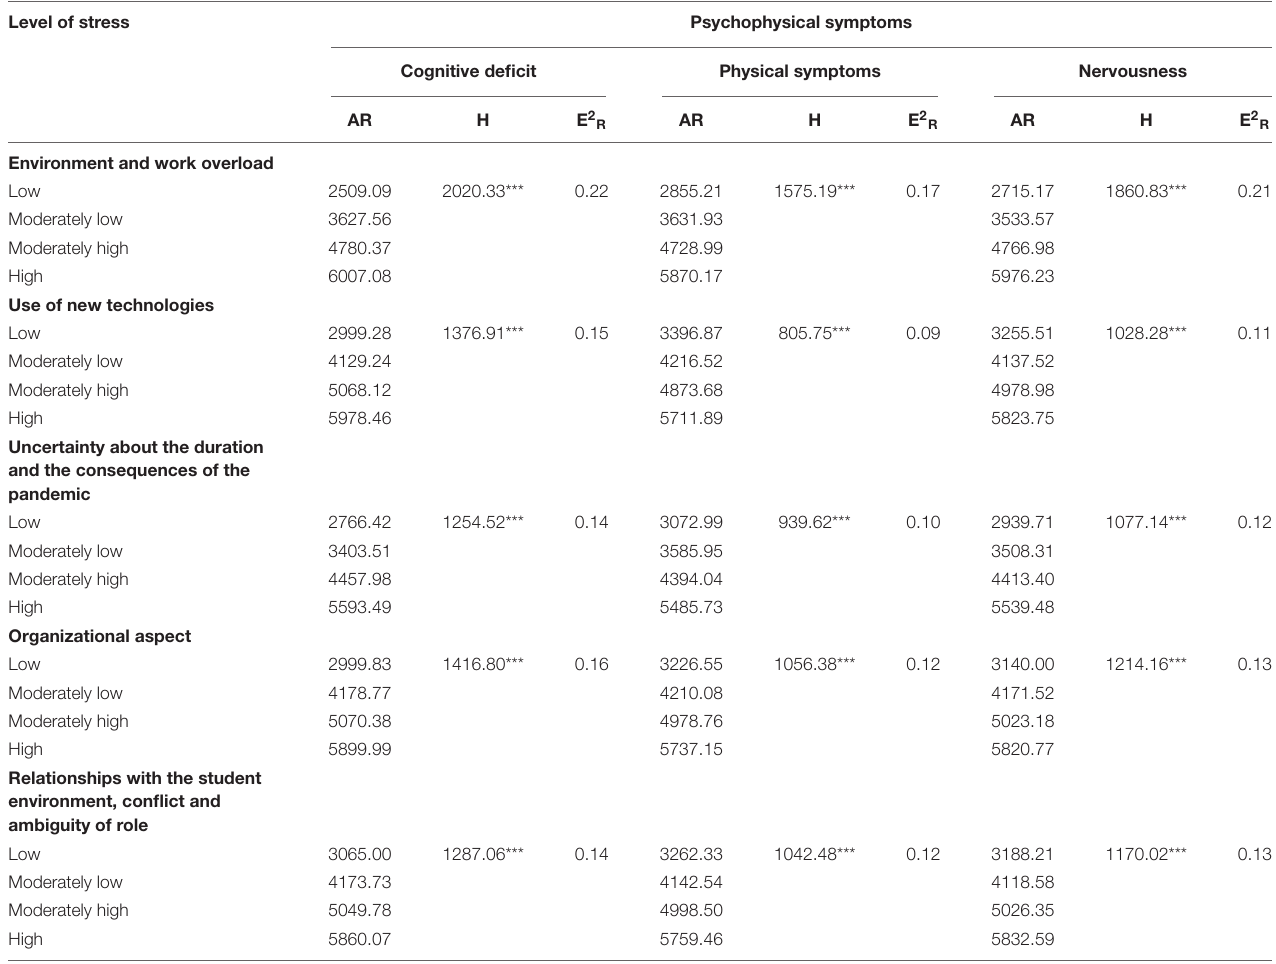
TABLE 3 | Results of the Kruskall Wallis test for the Psychophysical symptoms according to the Level of stress. Level of